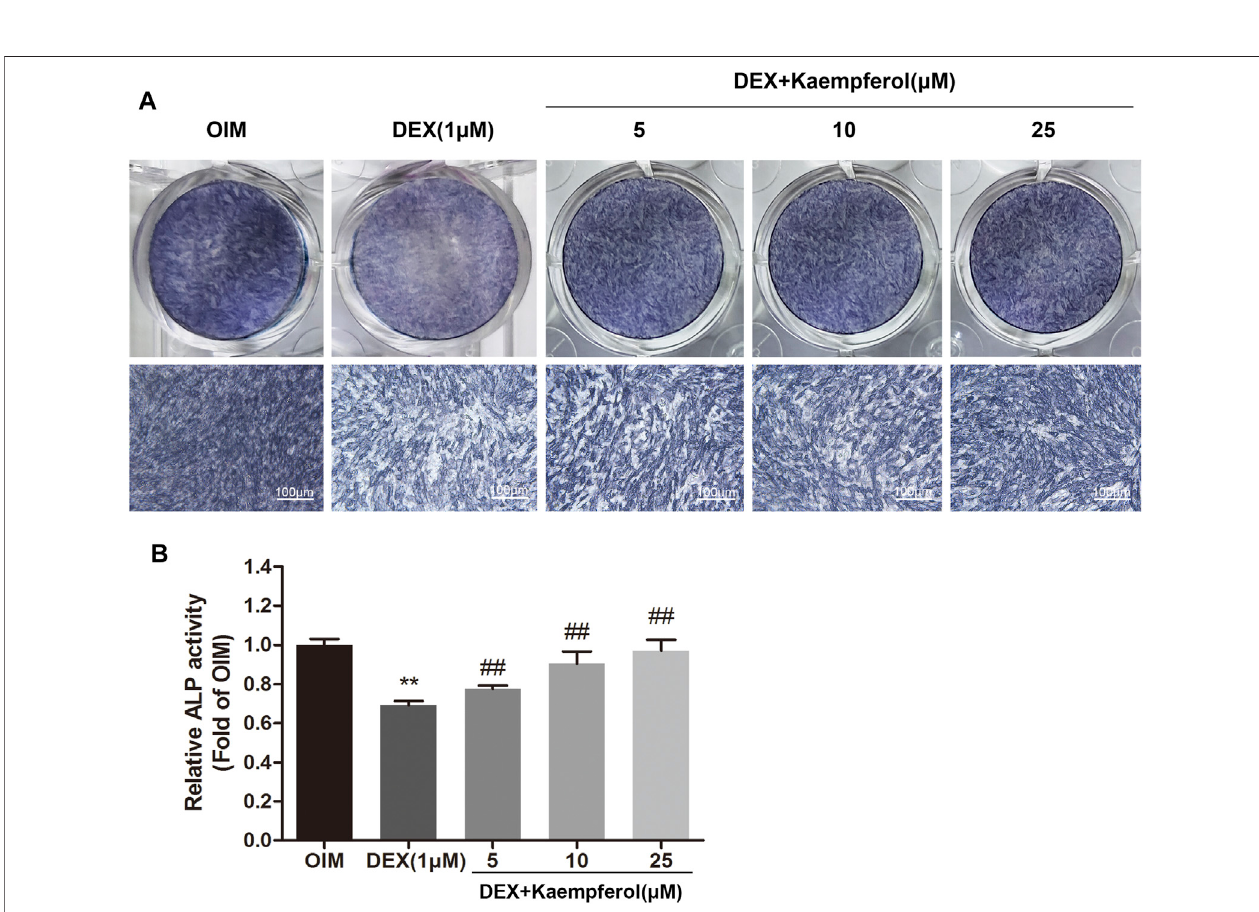
FIGURE 5 | The effect of kaempferol on the ALP activity in DEX-treated MC3T3-E1 cells. (A) BCIP/NBT staining was conducted. (B) The ALP activity was determined after 5-days co-treatment of MC3T3-E1 cells with kaempferol (5, 10, and 25 μ M) and DEX (1 μ M) in OIM. ** p < 0.01 vs. OIM; ## p < 0.01 vs. DEX.